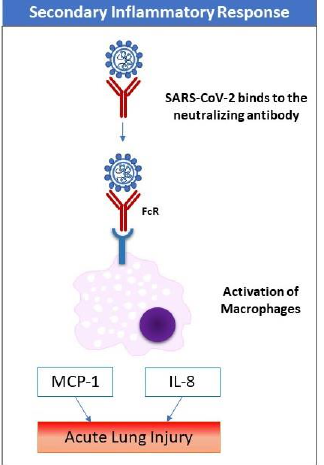
Figure 2. Inflammatory responses triggered by SARS-CoV-2 infection. Two inflammatory pathways may be distinguished. The primary pathway occurs as an early response to viral infection before the development of neutralizing antibodies (NAb). The secondary pathway begins with the release of Nab, which signifies the development of adaptive immunity. Triggering the FcR-mediated-inflammatory response is mediated by the virus-NAb complex and may lead to acute lung injury through several pathways including the release of monocyte chemoattractant protein-1 and interleukin-8 (IL-8) from macrophages. FcR can be blocked by IVIG, thus suppressing and pacifying the exuberant immune response. Several clinical trials have been registered to investigate the use of intravenous immunoglobulins (NCT04261426 and NCT04264858) or the convalescent plasma of recovered patients (NCT04342195) to treat severe cases of COVID-19. The role of IVIG in severe infections and sepsis is still controversial and warrants further well-designed clinical trials. While a previous randomized trial showed no benefit of IVIG on sepsis-related mortality [2,3,53,54], meta-analyses have shown a reduction in mortality, in particular with the use of IgA- or IgM-enriched IVIG [4,5,55,56].